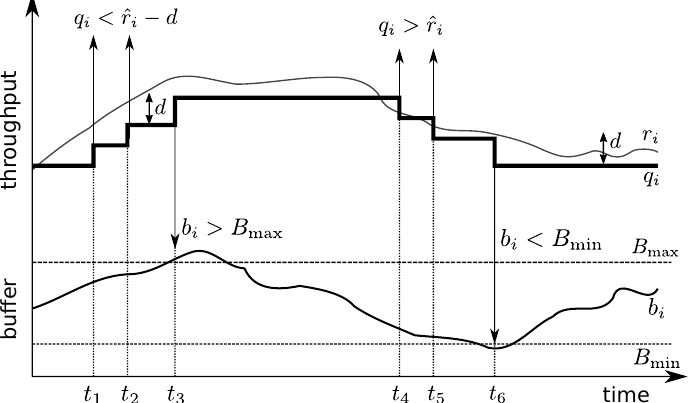
Figure 2. An example operation of a simplified version of the MSS algorithm. At times t 1 and t 2 , network throughput is high enough to increase the video bit rate (2e). At t 3 , the buffer level, which is above the threshold, allows increasing the video bit rate again (2a). At times t 4 and t 5 , network throughput drops, which causes the video bit rate to decrease (2c). At time t 6 , the buffer level drops below the threshold, and the video bit rate is reduced again (2b). After t 6 , network throughput is not high enough to increase the video-bit rate